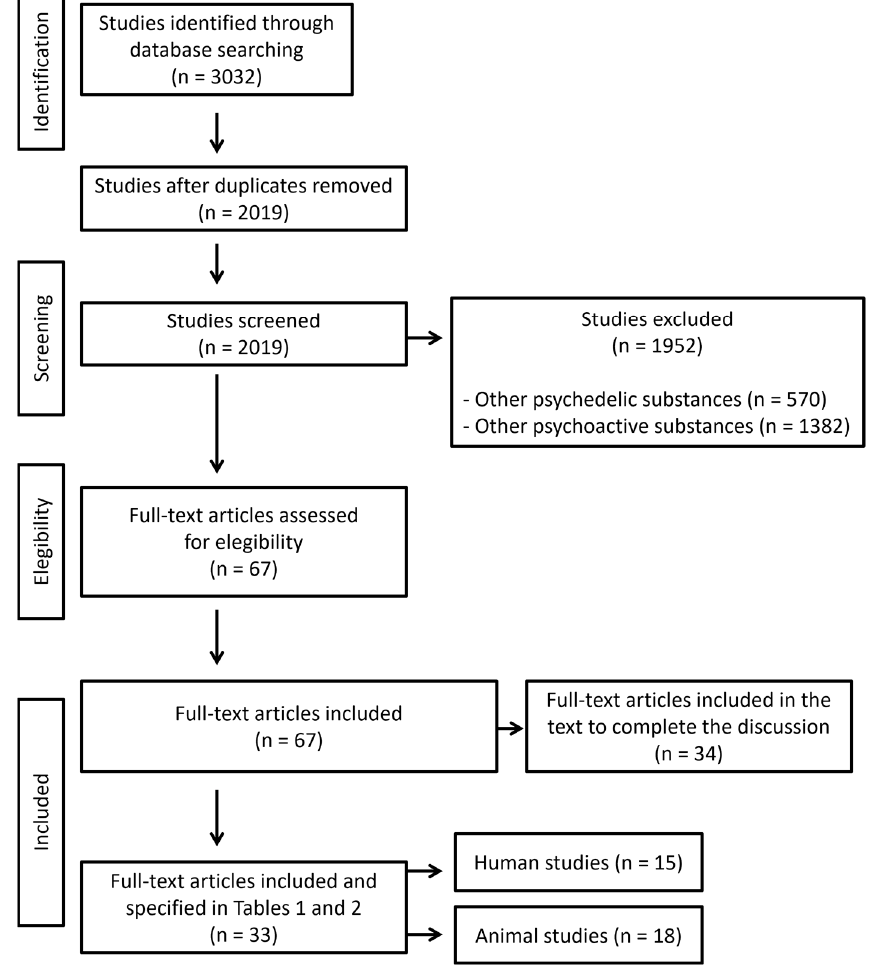
Figure 2. Flow diagram illustrating included and excluded studies in this systematic review. Articles reporting dosage are included in Tables 1 and 2 (n = 33), while articles reporting information that may explain clinical outcome are included in the text to complete the discussion (n = 34).